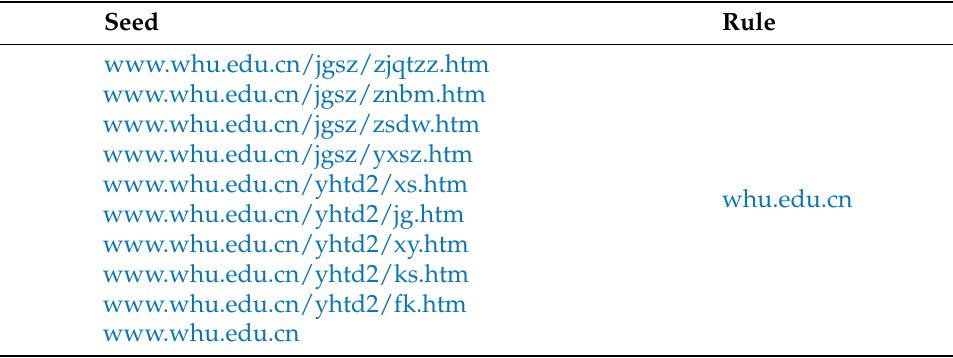
Table 3. Parameters of a network asset detection example for Wuhan